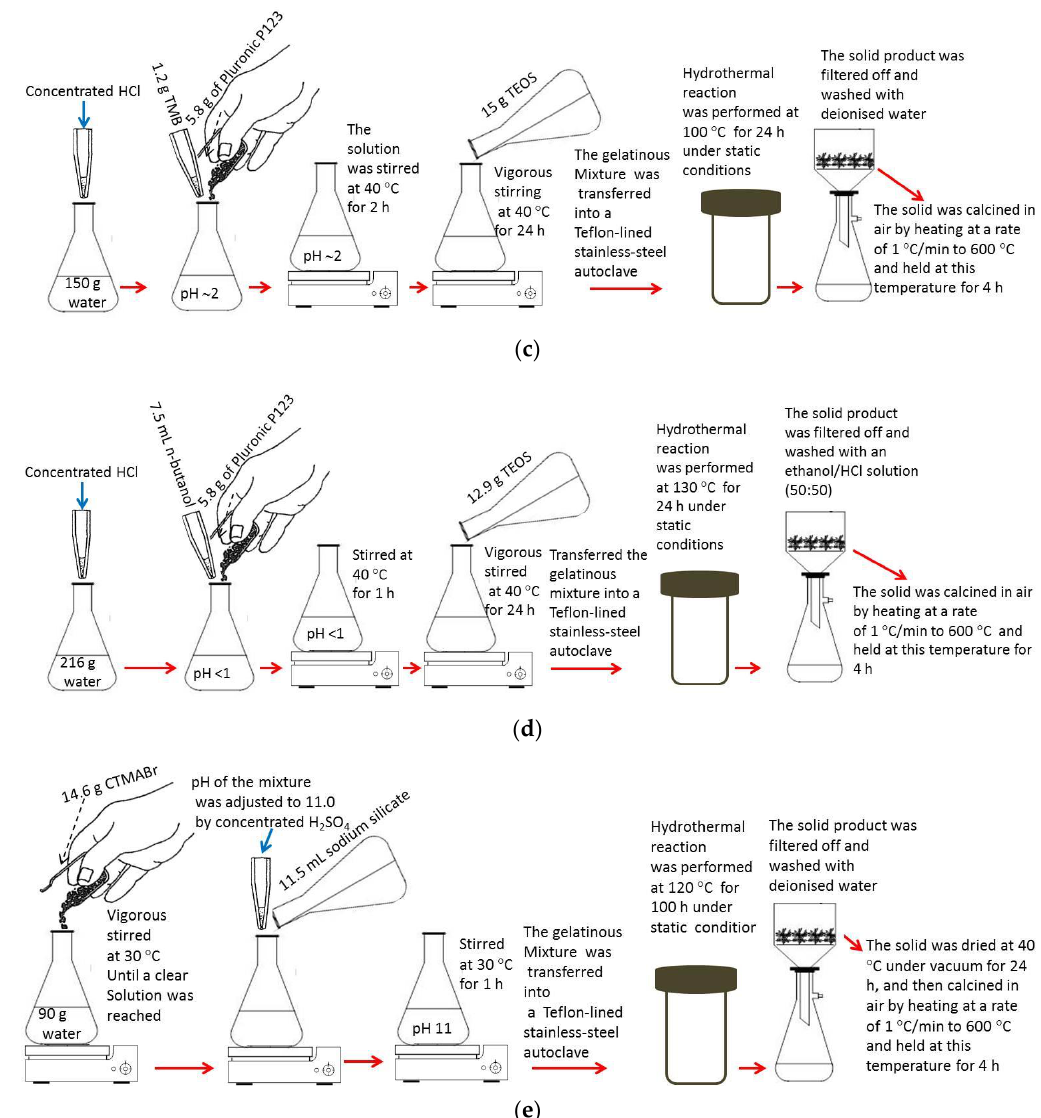
Figure 13. The schematic illustration of the typical synthesis procedure for the materials: ( a ) SBA-15, ( b ) TMS, ( c ) MCF, ( d ) KIT-6 and ( e ) MCM-41.